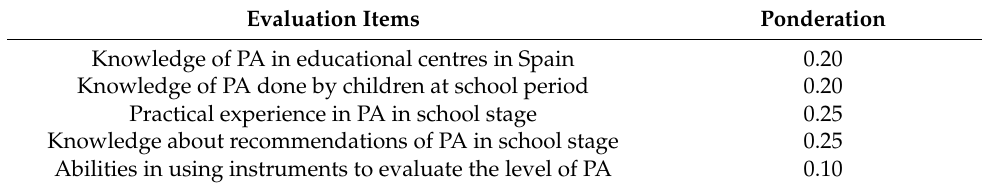
Table 1. Knowledge coefficient (Kc)